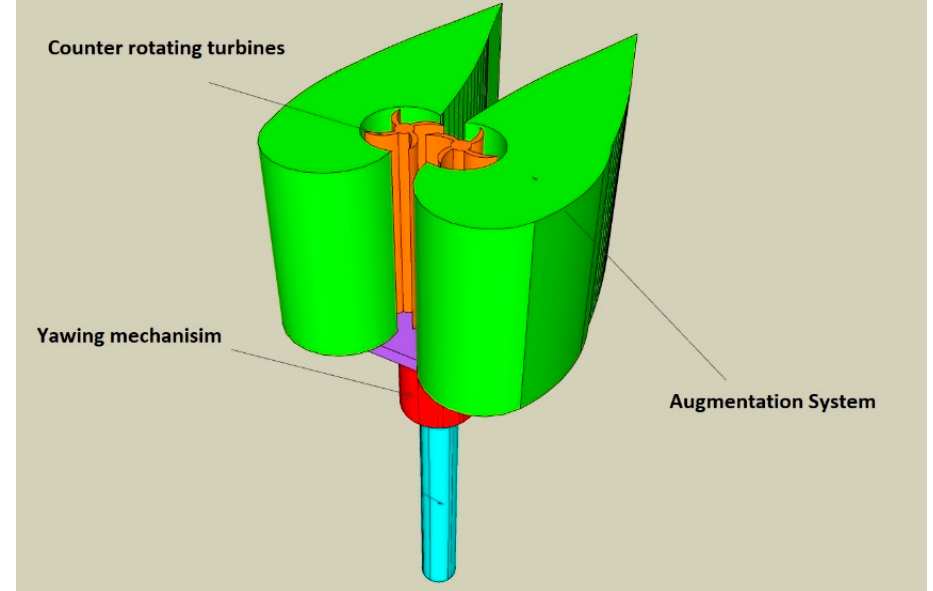
Figure 1. CAD drawing of the proposed augmentation system.